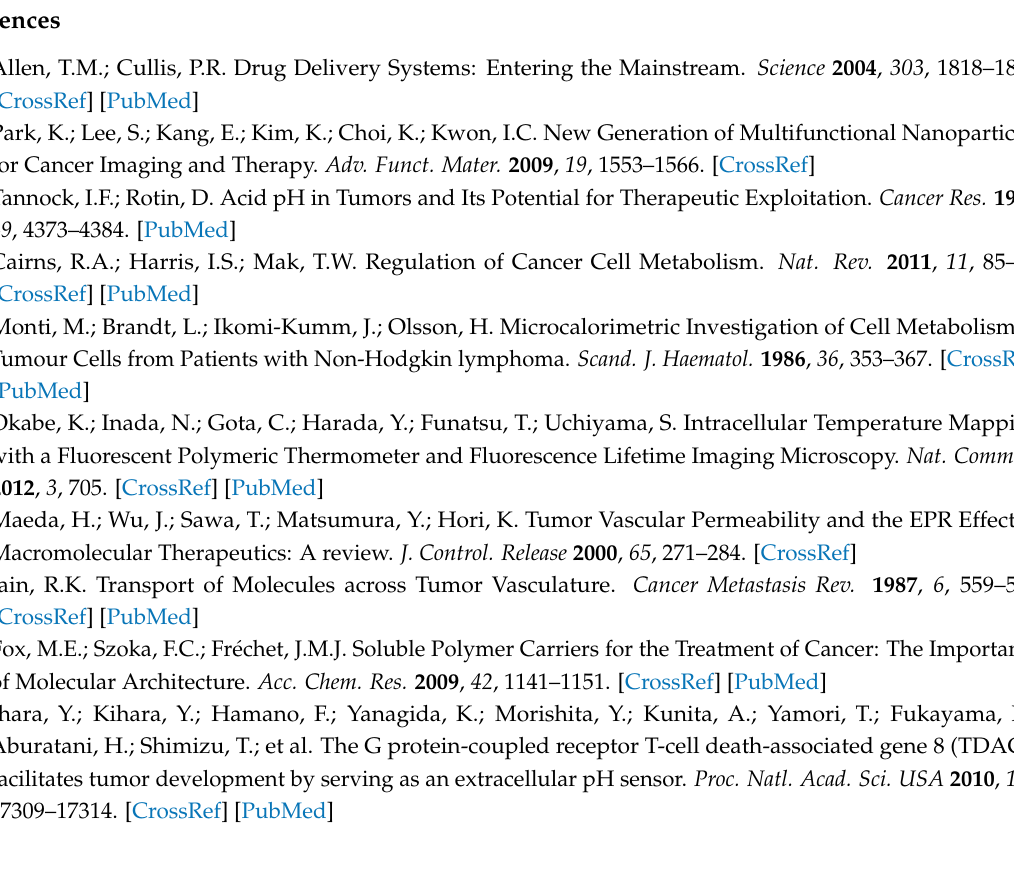
Figure S3: Temperature dependence of fluorescence spectra of TFMAQ-diEg4. Figure S4. Illustrations of mouse that are controlled the body temperature. (a) and (b) indicate the condition without and with the local heating around tumor